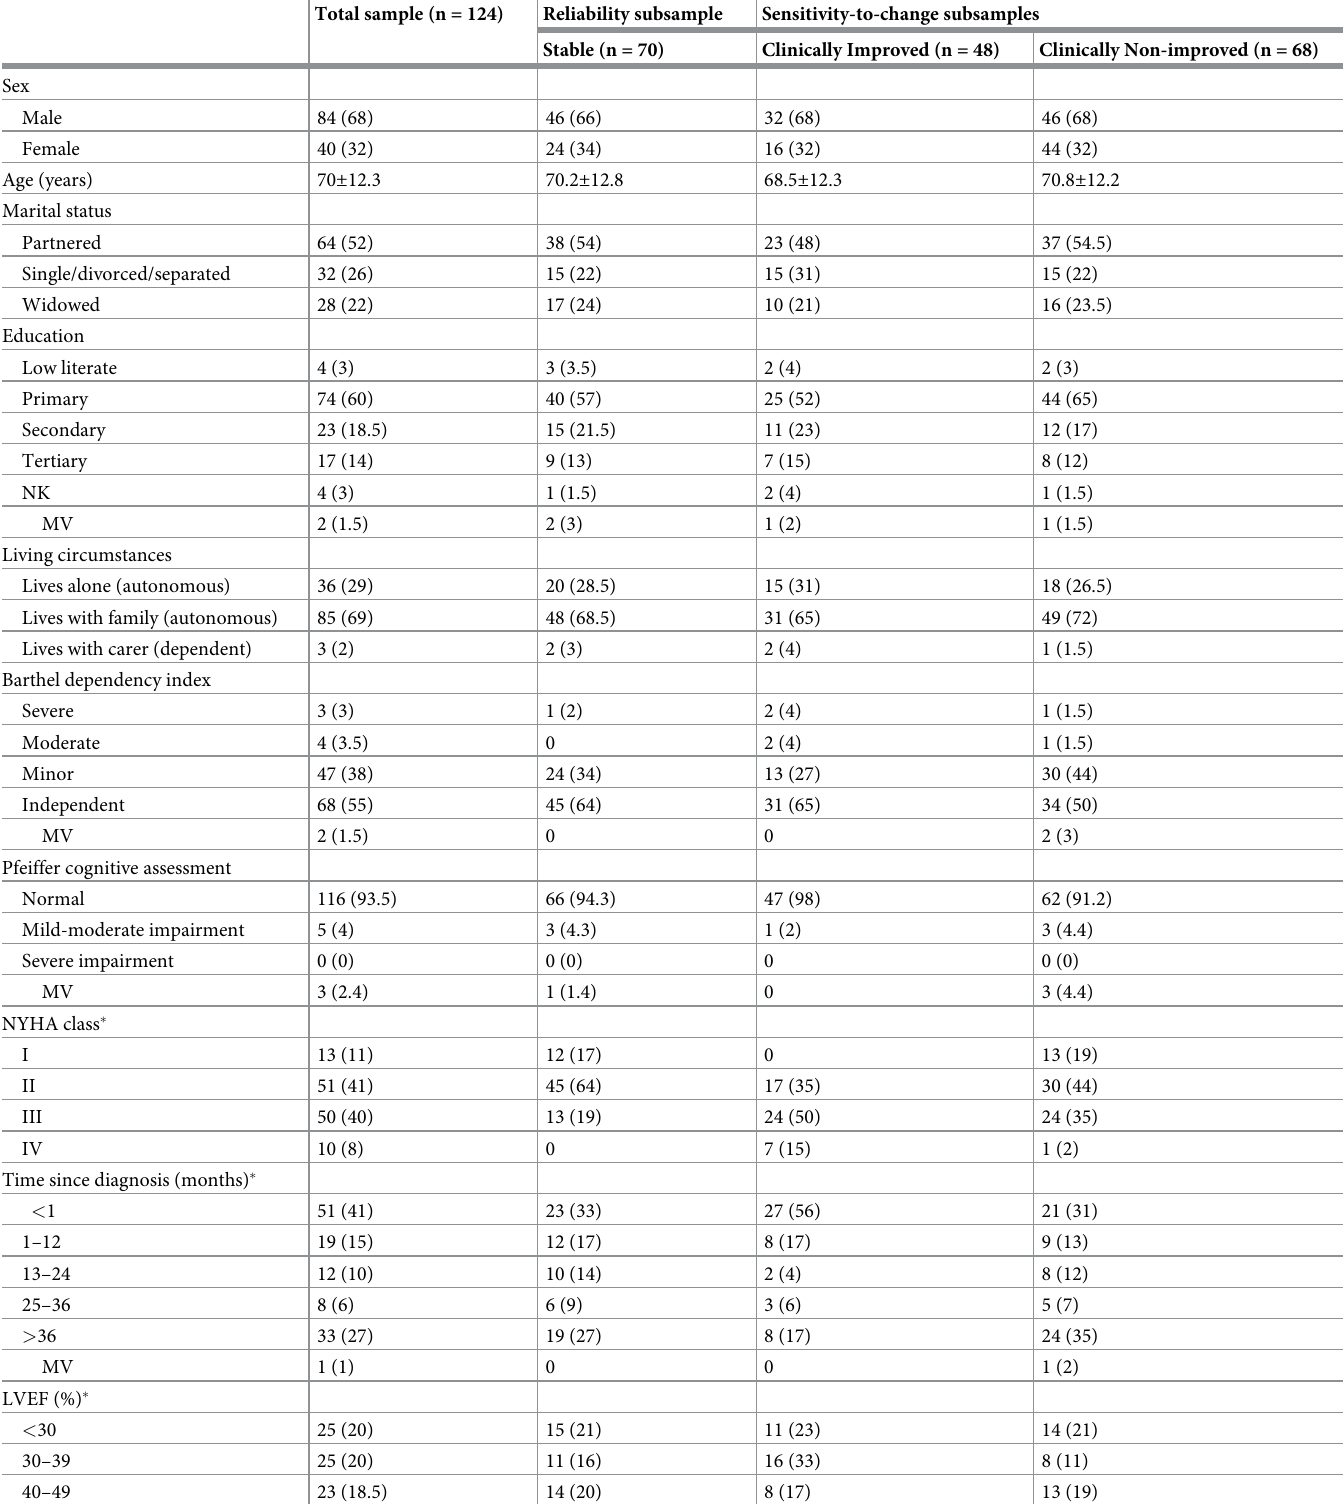
Table 1. Patient baseline sociodemographic and clinical